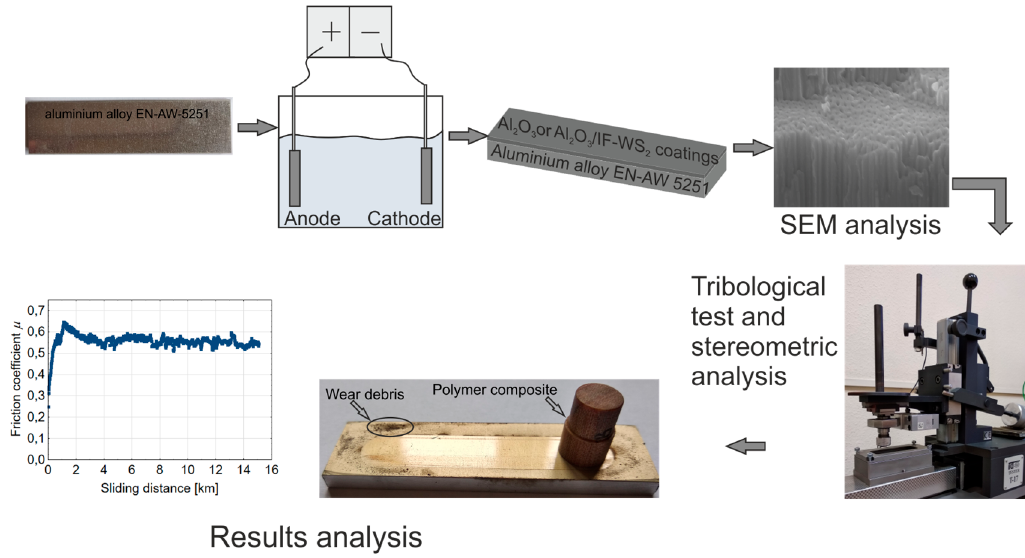
Figure 1. Schematic representation of the study.